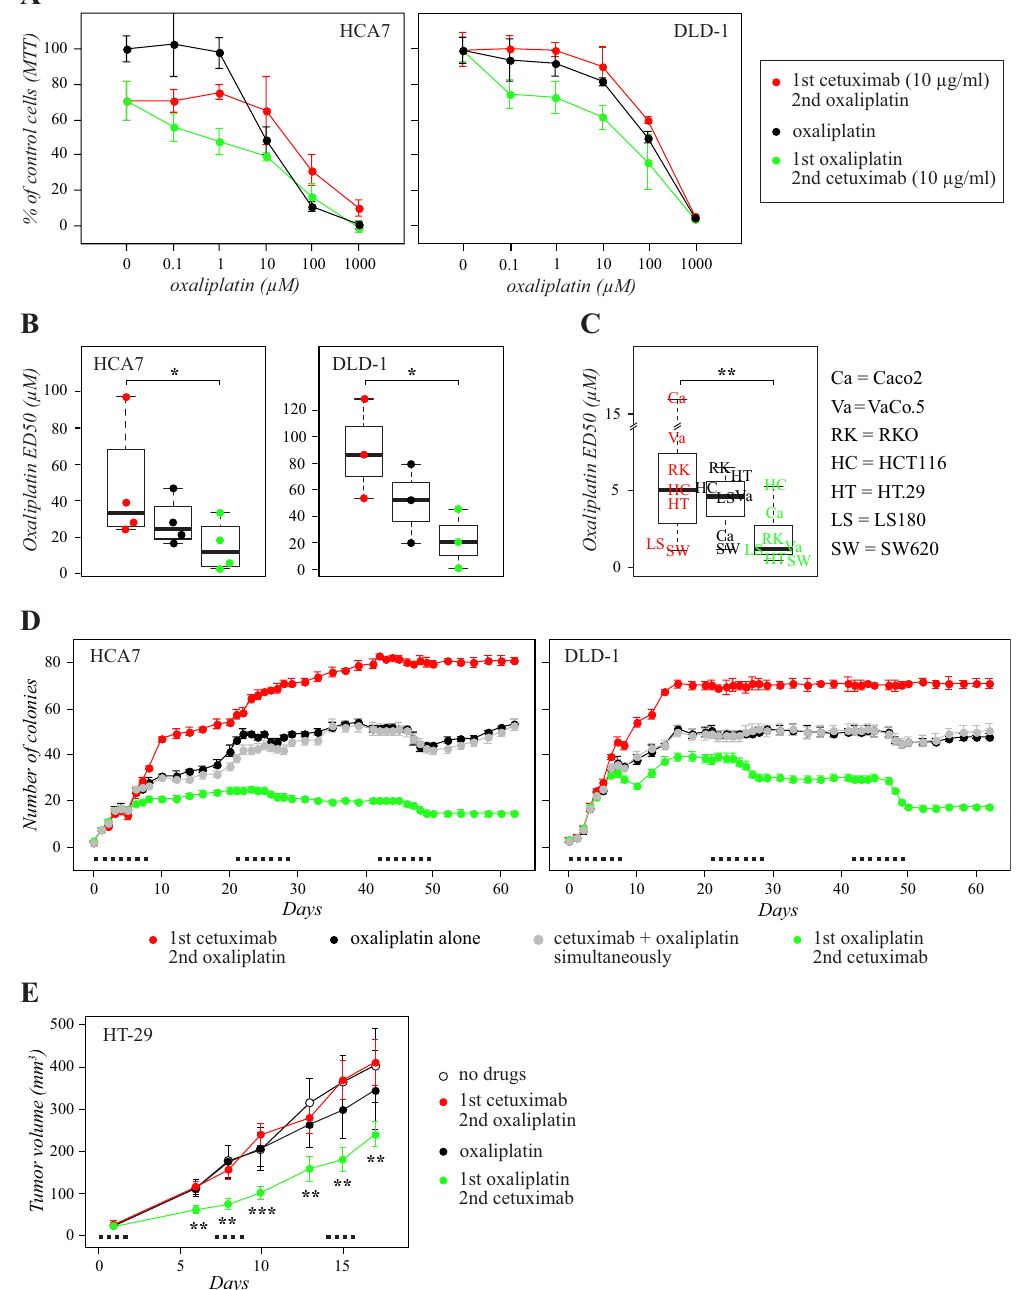
Figure 1. Sequence of administration determines the effect of the regimen including cetuximab and oxaliplatin. Sequential administration of cetuximab before or after oxaliplatin was compared to administration of oxaliplatin alone using MTT ( A – C ), soft agar ( D ), and mouse xenograft ( E ) growth assays. ( A – C) Cells were (1) treated for 24 hours (for day 3 of the experiment) with the indicated concentrations of oxaliplatin alone (black curves), (2) treated first for 48 hours (days 1 and 2) with 10 μ g/ml cetuximab followed by 24 hour (day 3) treatment with the indicated concentrations of oxaliplatin (red curves), or (3) treated first for 24 hours (day 3) with oxaliplatin followed by 48 hour (days 4 and 5) treatment with 10 μ g/ml cetuximab (green curves). MTT analysis was carried out after day 5 of the experiment. ( A ) Representative MTT experiments of HCA7 (left panel) and DLD-1 (right panel) cells. Mean + / − SD is shown. ( B ) Oxaliplatin ED50 values of sequential treatments from 3–4 independent experiments with HCA7 and DLD-1 cells. ( C ) Oxaliplatin ED50 values of sequential treatments from single independent experiments with the seven indicated cell lines. The box plots indicate the median, the second and third quartiles, and the range of the data. * P < 0.05; ** P < 0.01. ( D) HCA7 (left panel) and DLD-1 (right panel) cells suspended in soft agar were (1) treated for 48 hours (for days 4 to 5 of each treatment cycle) with oxaliplatin alone (black curves), or (2) in simultaneous combination with cetuximab (grey curves), (3) treated first for 72 hours (days 1 to 3) with cetuximab followed by 48 hour (days 4 to